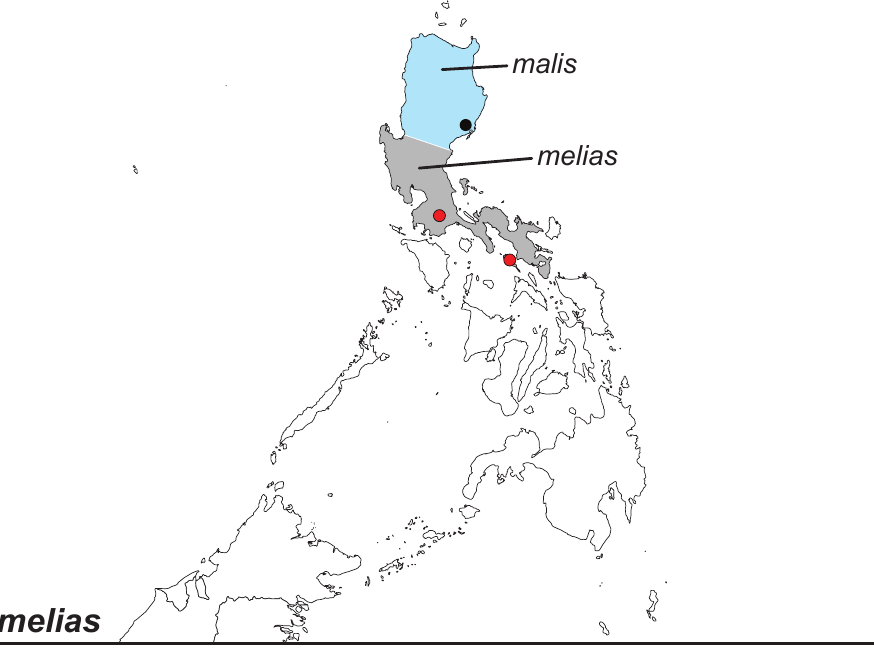
Figure 61. Distribution map of Elymnias melias .